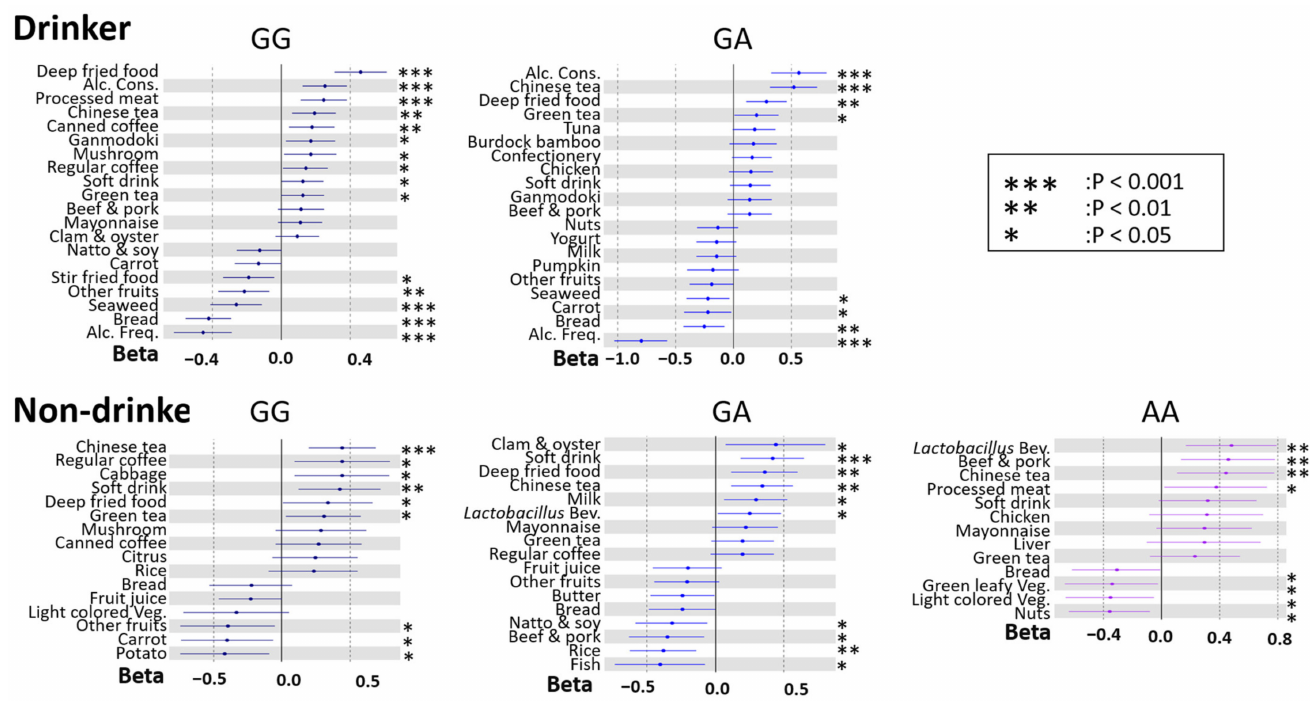
Figure 4. Forest plot showing associations between dietary behaviors (DBs) and BMI for each rs671 genotype in males. The X -axis and Y -axis show the standardized beta coefficient ± standard deviation and each DB, respectively. Dark blue, blue, and purple spots indicate the results for GG, GA, and AA types of rs671 genotypes, respectively. Alc. Cons, alcohol consumption; Alc. Freq., alcohol frequency; Lactobacillus Bev., Lactobacillus beverage; Green leafy Veg., green leafy vegetable; Light-colored Veg., light-colored vegetable; Green-yellow Veg, green-yellow vegetable. Asterisks indicate statistical significance for heterogeneity (***, p < 0.001; **, p < 0.01; *, p <